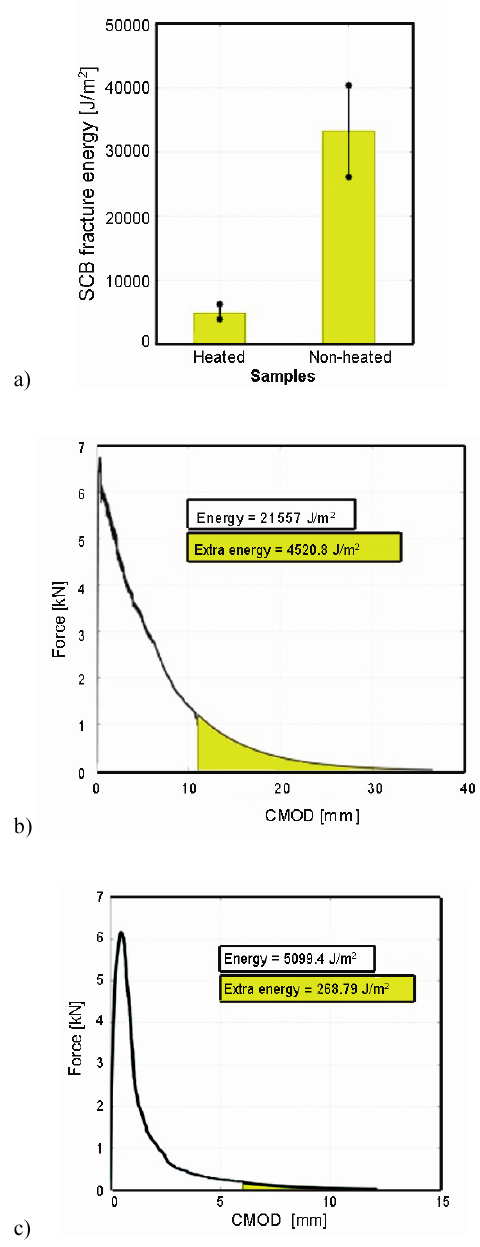
Fig. 8. Results from the SCB testing: a) The total fracture ener- gy for SCB specimens cut from zones at the top and middle of cylinders, star markers indicate the value range, the bar presents the mean value; b) Example of Load-CMOD curve for untreated SCB specimens; c) Example of Load-CMOD curve for heat treated SCB